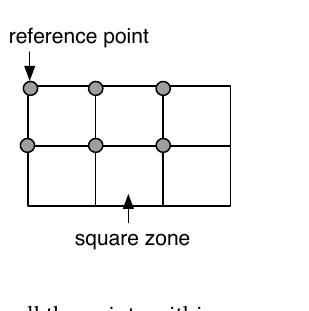
Figure 3. Reference system for GPS traces: all the points within a square zone are approximated with the coordinates of the reference point in the top left corner of the same